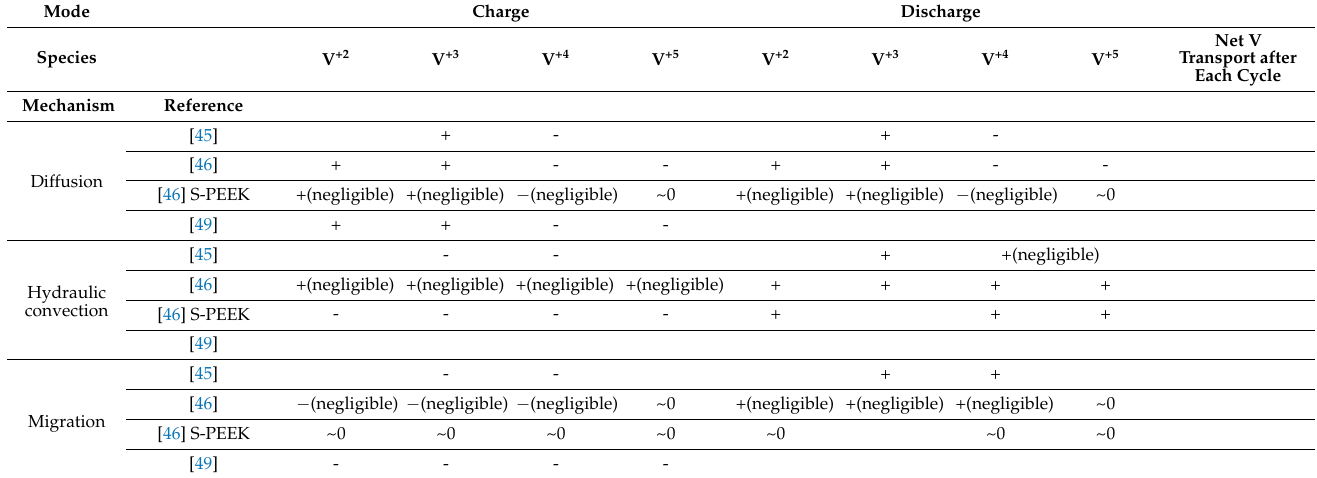
Table 1. Direction of vanadium species transport during charge and discharge—data corresponding to S-PEEK are identified, and the rest correspond to